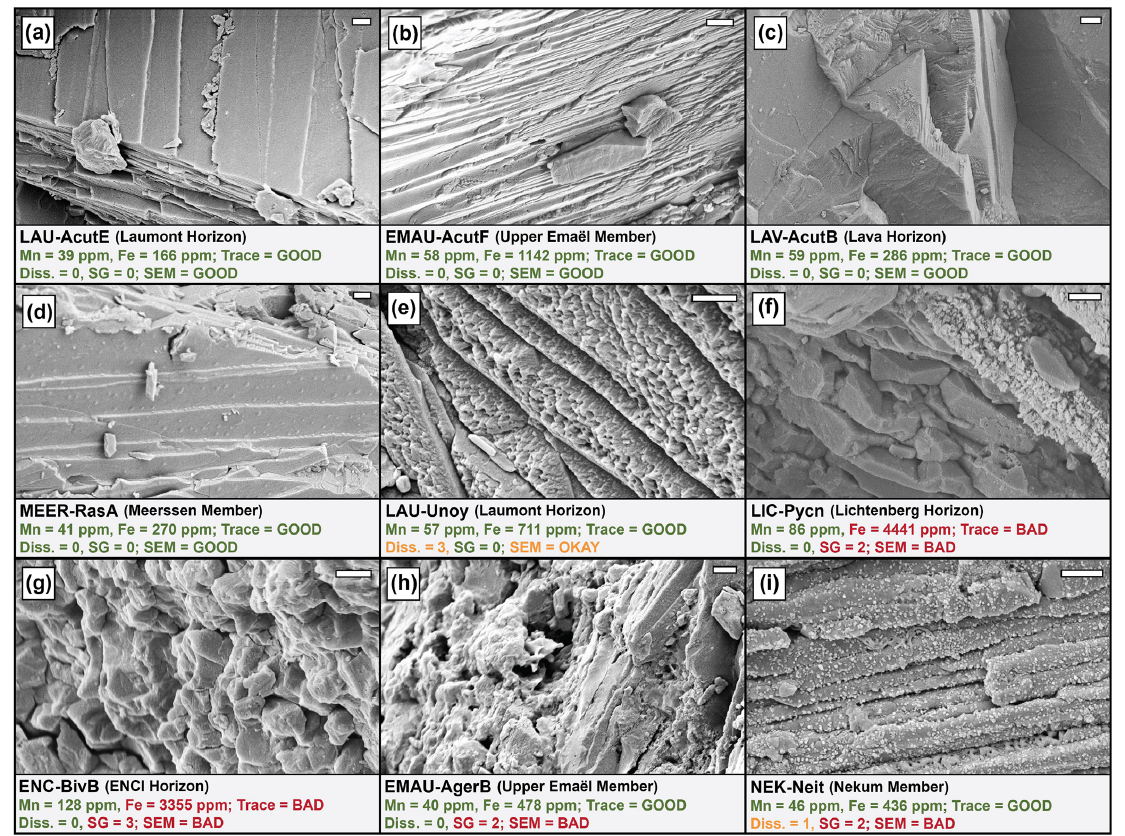
Figure 3. SEM images of nine shell specimens representing varying levels of calcite preservation. Scale bars represent 1µm. Images were adjusted for brightness in Adobe Photoshop 2022. Trace element concentrations (in ppm) and SEM preservation indices quantifying the level and prevalence of dissolution and secondary growth (SG) on a scale of 0–3 are shown below each image for comparison. Samples in (a) through (e) were interpreted. Samples in (f) through (i) were not interpreted further due to too much evidence of secondary growth and/or trace elements exceeding thresholds (see Fig.